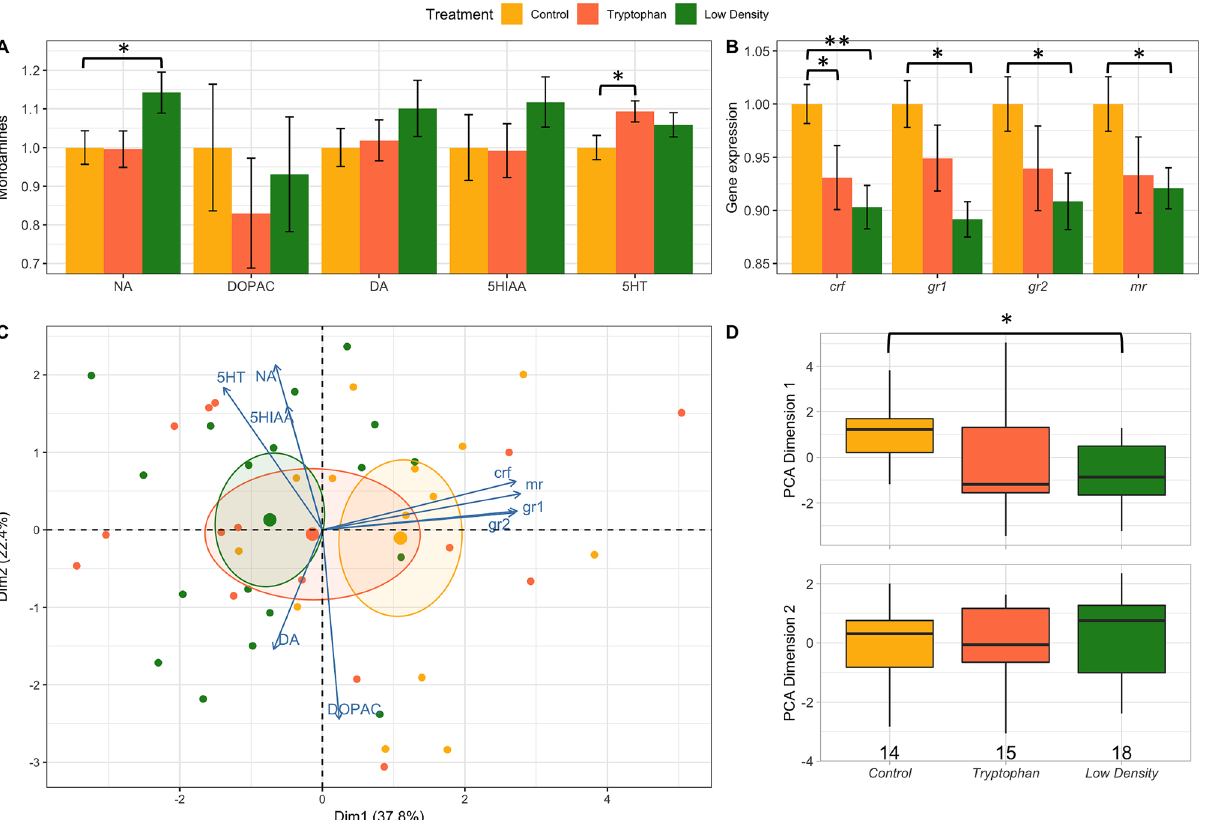
Figure 3. Overall view of ( A ) monoamines detected in the telencephalon and ( B ) stress-related genes detected in the hypothalamus ( crf, mr, gr1, gr2 ) of fish sampled at 132 dph in the 3 treatments: Control, Low density and Tryptophan. Note that gene values are relative to the geometric mean of the following referencegenes: ribosomal protein L13 ( L13 ) and eukaryotic translation elongation factor 1 alpha ( eef1a ). Each bar plot represents the difference in % between Control and the other treatments. ( C ) Represent output of the Principal Component Analysis (PCA), based on monoamines and gene expression in each individual. ( D ) The coordinates of each individual within each treatment for the first and the second axis are represented by box plots that show the median, which is represented by lines, and the first and third quartiles. “*” indicates a p value < 0.05 and “**” indicates a p-value <